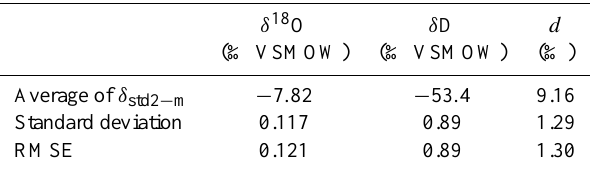
Table 3. Results of standard 2 measurements ( δ std2 − m ) normalized to the VSMOW2-SLAP2 scale by using standards 1 and 3 as work- ing standards, following the IAEA Reference Sheet (IAEA, 2009). Statistics are calculated from the set of 40 calibrations. Standard de- viation provides the reproducibility, and the root mean square devi- ation from the known value (RMSE) provides the accuracy of liquid measurements. δ 18 O δ